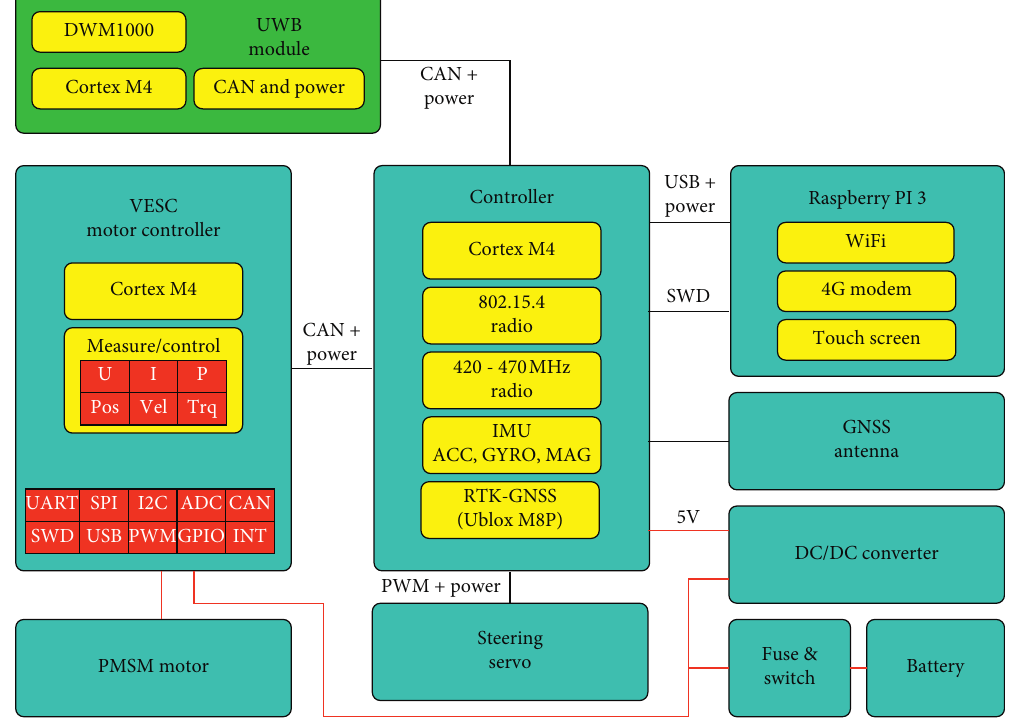
Figure 2: Block diagram of our self-driving model car with our UWB module in